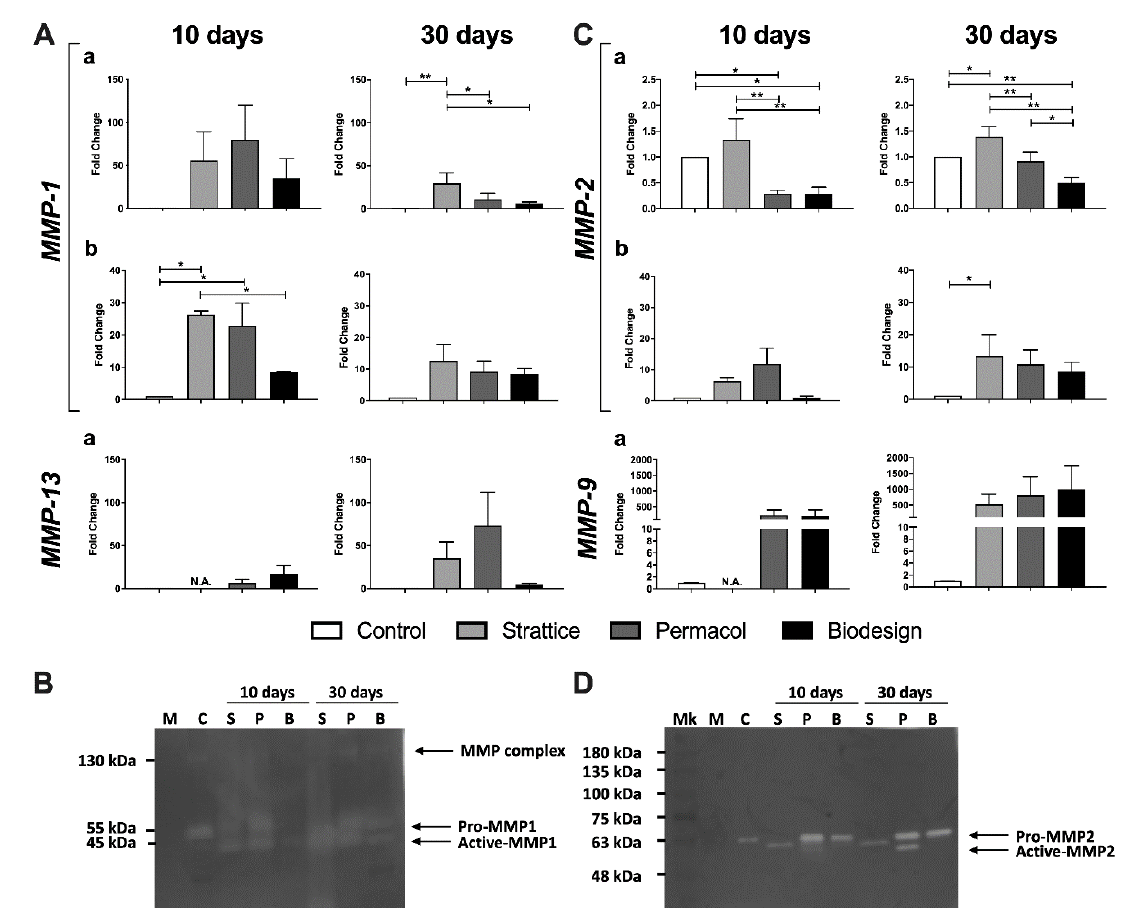
Figure 4. Changes in the levels of metalloproteinases transcripts, proteins, and in their activity following growth on the different types of matrices for 10 or 30 days, compared to control condition. ( A ) Expression of MMP-1 and MMP-13 collagenases from fibroblasts grown on plastics (control), Strattice, Permacol, Biodesign at transcript (a) and protein (b) levels. ( B ) Representative image of collagen zymography using supernatants from fibroblasts grown on plastics (C), Strattice (S), Permacol (P), and Biodesign (B) for 10 and 30 days. Complete medium (M) was used as a negative control. ( C ) Expression of MMP-2 and MMP-9 gelatinases from fibroblasts grown on plastics (control), Strattice, Permacol, Biodesign at transcript (a) and protein (b) levels. ( D ) Representative image of gelatin zymography using supernatants from fibroblasts grown on plastics (C), Strattice (S), Permacol (P), and Biodesign (B) for 10 and 30 days. Complete medium (M) was used as a negative control. Values in ( A , C ) are means of four independent experiments ± SE. The results were analyzed with ANOVA. Asterisks indicate significant differences (* p < 0.05; ** p < 0.01). N.A. indicates that the sample was not analyzed since the amount of RNA extracted from the sample was not sufficient to analyze all genes of interest.